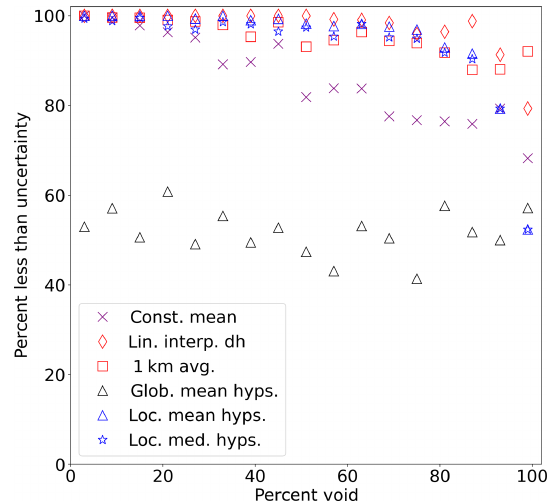
Figure 11. Percent of estimates that fall within the uncertainty esti- mates as a function of the void